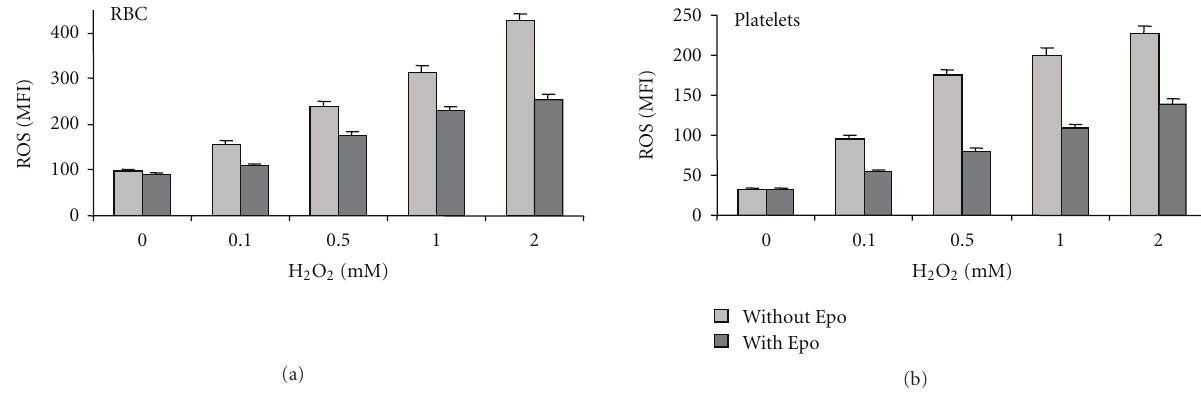
Figure 5: E ff ect of Epo on ROS production by H 2 O 2 -stimulated normal RBC and platelets. Diluted blood samples were treated with the indicated concentrations of H 2 O 2 for 30 min, then incubated with or without Epo (2U/ml) for additional 2hrs, washed and assayed for ROS. The results show the average ( N = 3) mean fluorescence index (MFI) ±